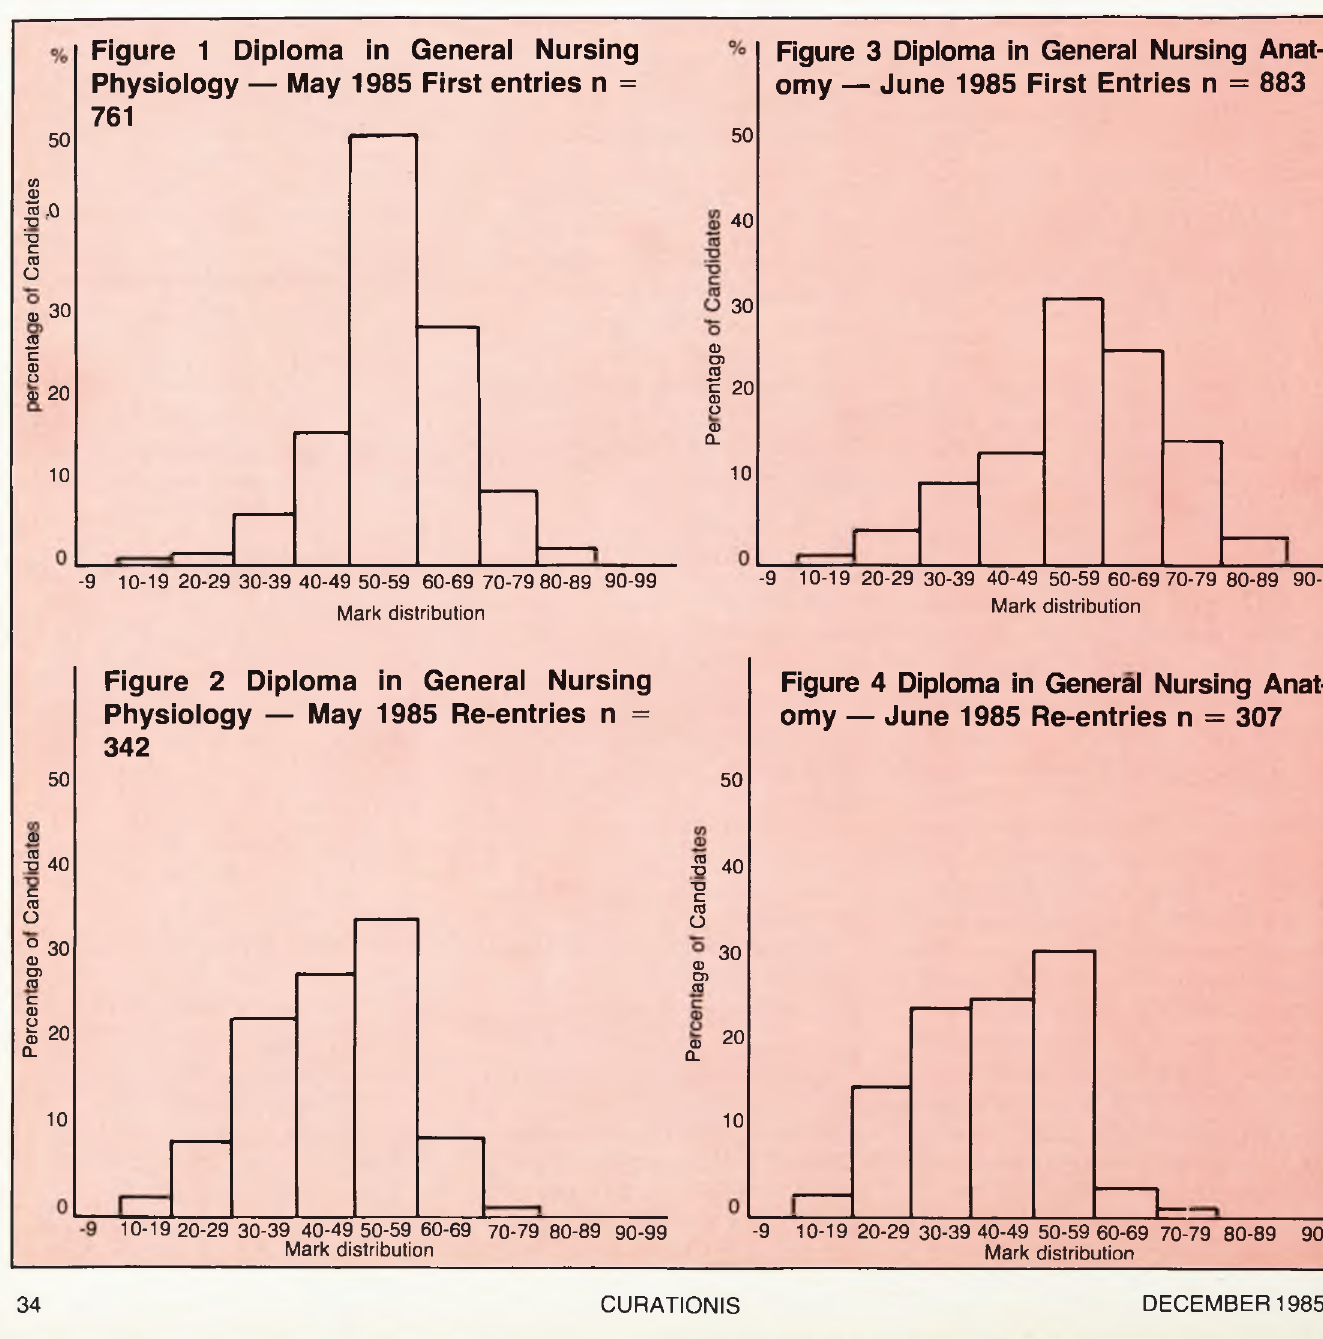
Figure 1 Diploma in General Nursing